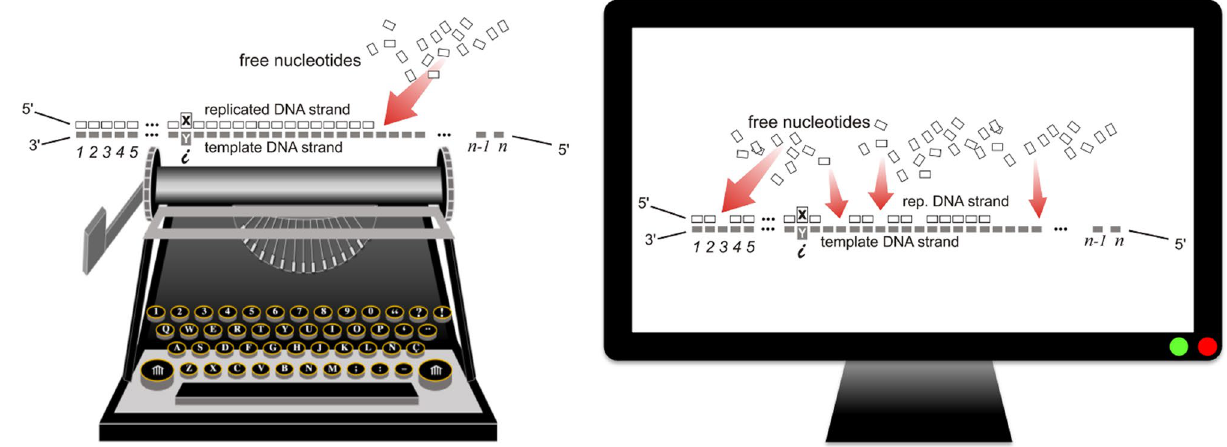
Figure 2. Analogy for the writing and revision statistics. The image on the left corresponds to the generation of a sequence of characters according to the directional statistics (writing): following the reading direction (from left to right in, for example, English language and sheet music, or from the 3’ end to the 5’ end of a DNA template strand during its replication), the characters are incorporated one by one, without backtracking or deletions; although errors may be detectable are not editable in a typewriting machine. The image on the right corresponds to the standard statistics (revision): the information is again interpreted according to